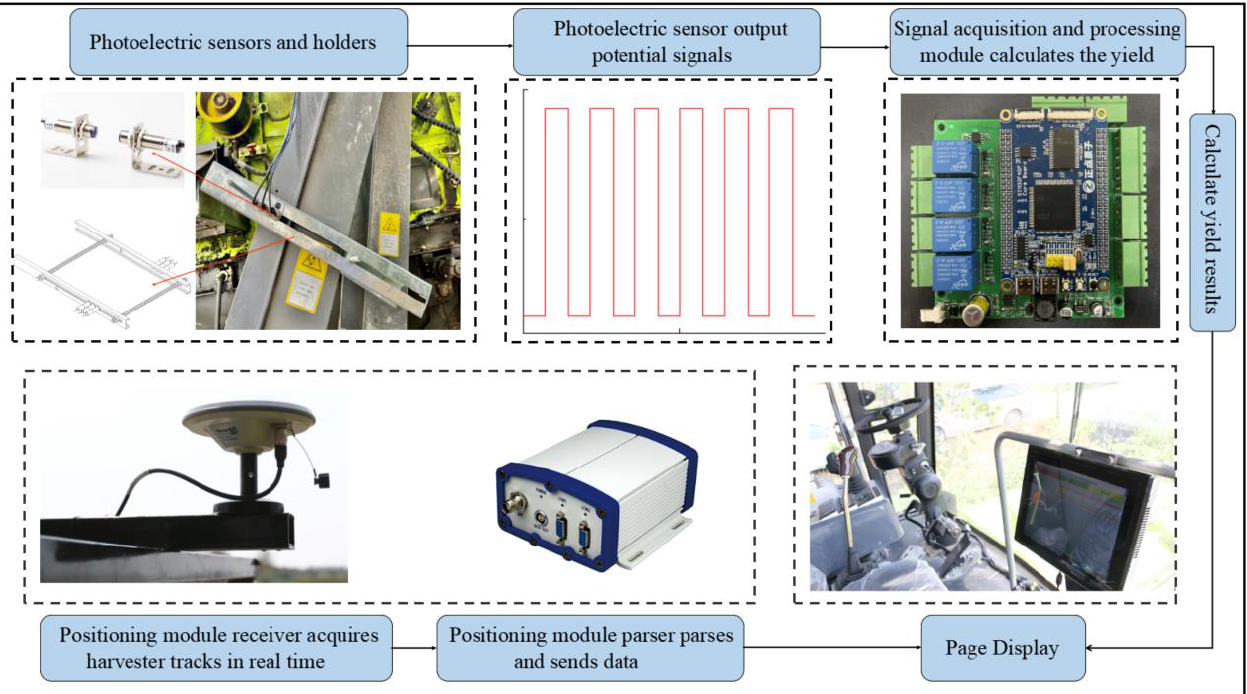
Figure 2. Schematic diagram of yield monitoring